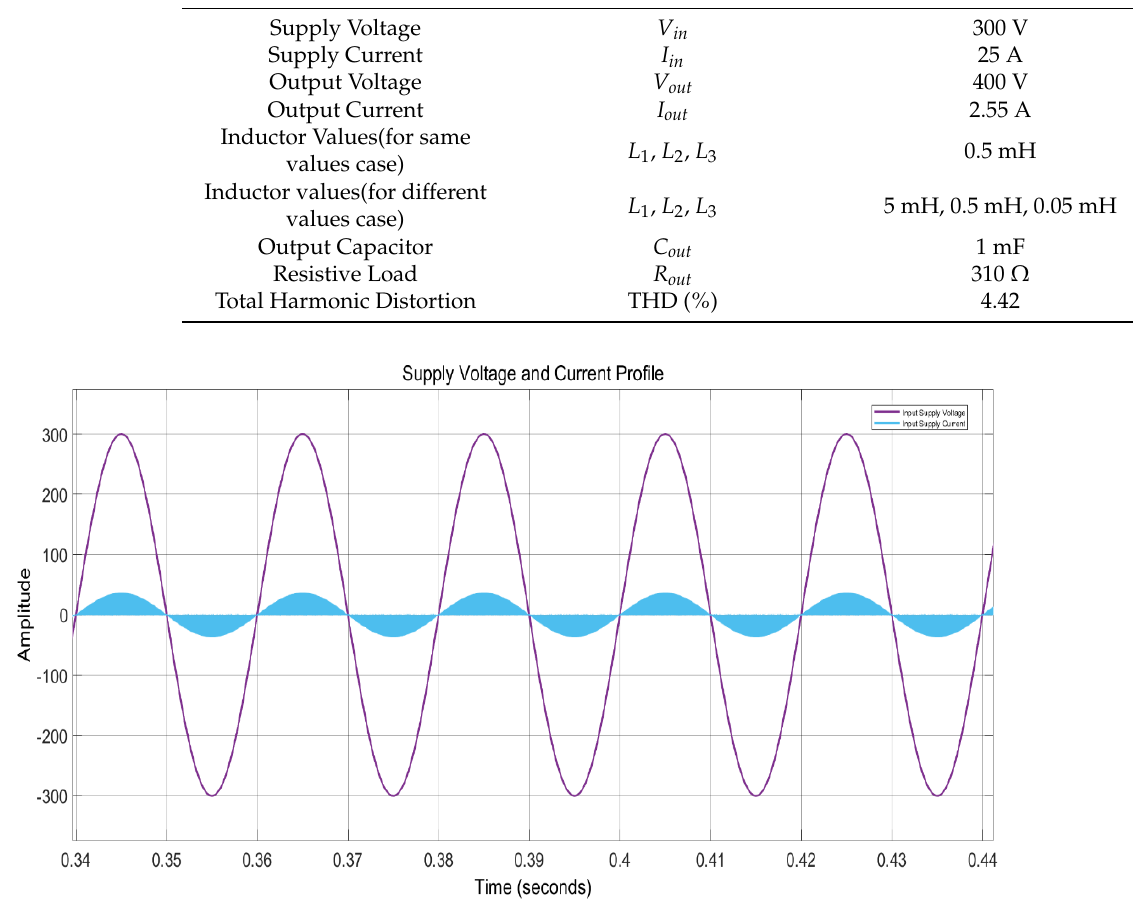
Figure 8. Sinusoidal input supply voltage and current.